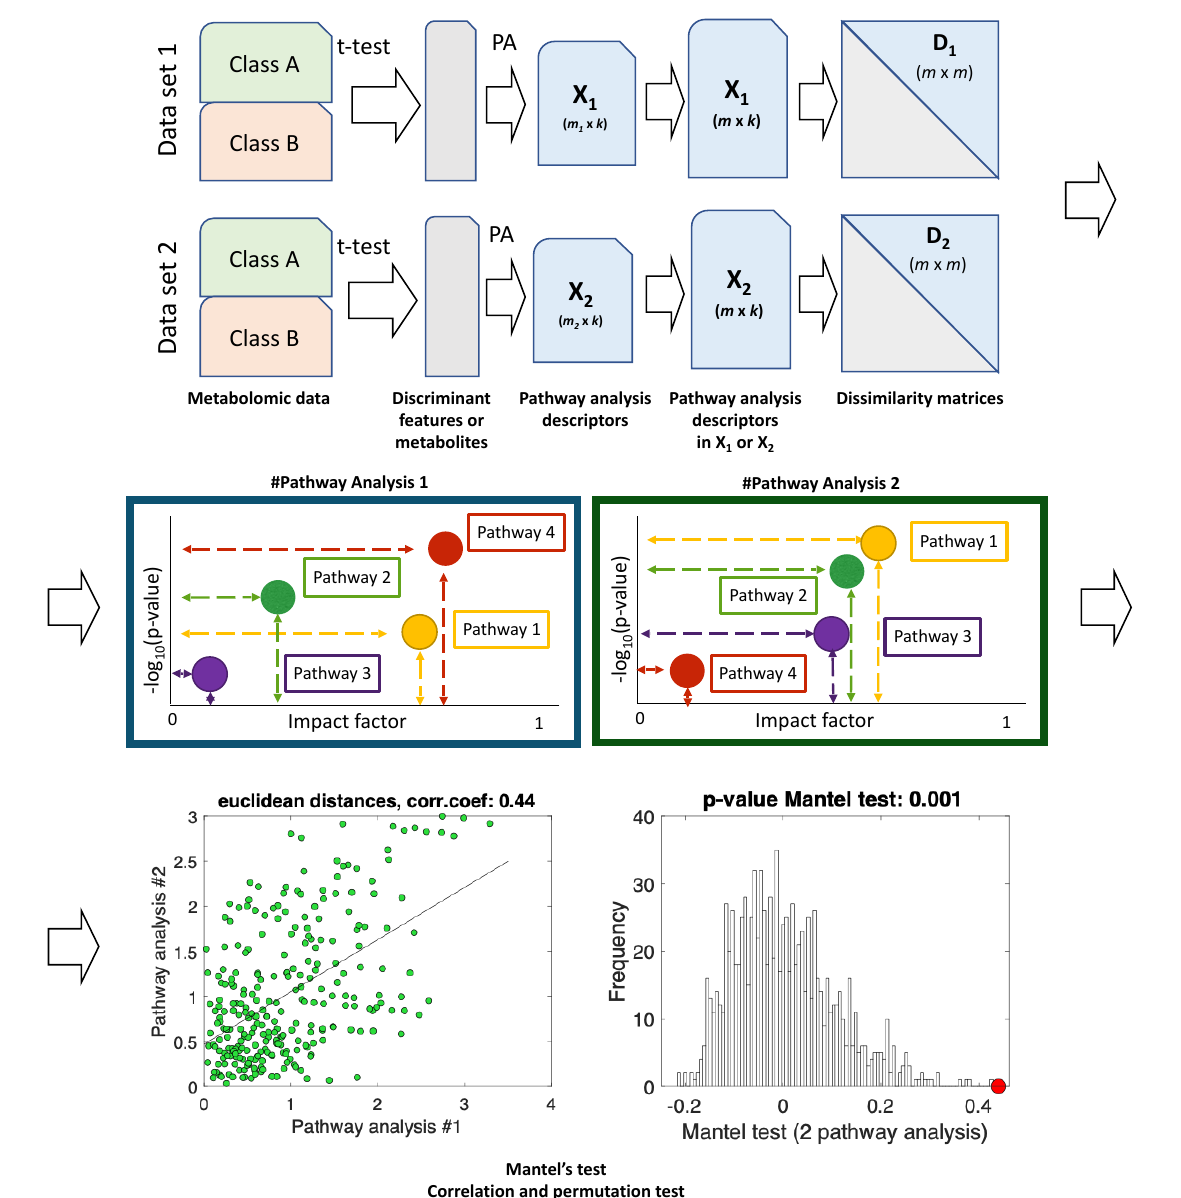
Figure 5. Schematic workflow for the functional correlation analysis of results from metabolic pathway analysis. Metabolomics data between two groups is compared by t-test analyses in two different datasets. Discriminant features or metabolites are identified, and metabolic pathway analysis performed. Results from pathway analysis are summarized with 2 k descriptors (the log10 ( p -value), and the enrichment or impact factor) as coordinates of two data matrices X1 (m1 × k) and X2 (m2 × k) (m = pathways). As the number and identity of the pathways included in the results may vary across studies, for those pathways present in a single analysis, the p -values and the enrichment or impact factors are imputed as 1, and 0, respectively, in the other one (X1(m × k), X2(m × k). For each matrix × (m × k), a distance or dissimilarity matrix is computed (i.e., D1(m × m) and D2(m × m)) using a selected measure such as the Euclidean or the standardized Euclidean distance. Then, the lower triangular part of each dissimilarity matrix is unfolded into two vectors (d1 and d2) to calculate the pairwise linear correlation coefficient, (e.g., Pearson coefficient, or the rank-based Spearman correlation coefficient if non-linearity is expected) between them. The statistical significance of the calculated correlation coefficient between pathway analysis #1 and #2 is estimated using a permutation test and the correlation coefficient is computed for each permutation. Original figure from